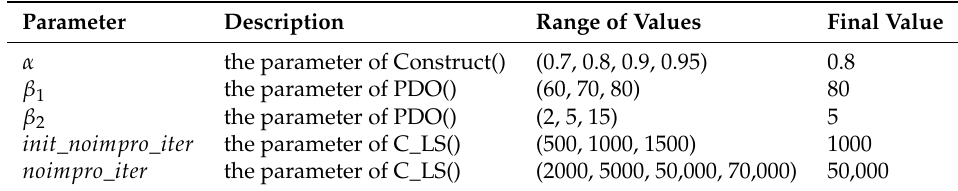
Table 1. The parameter settings of our proposed algorithm.